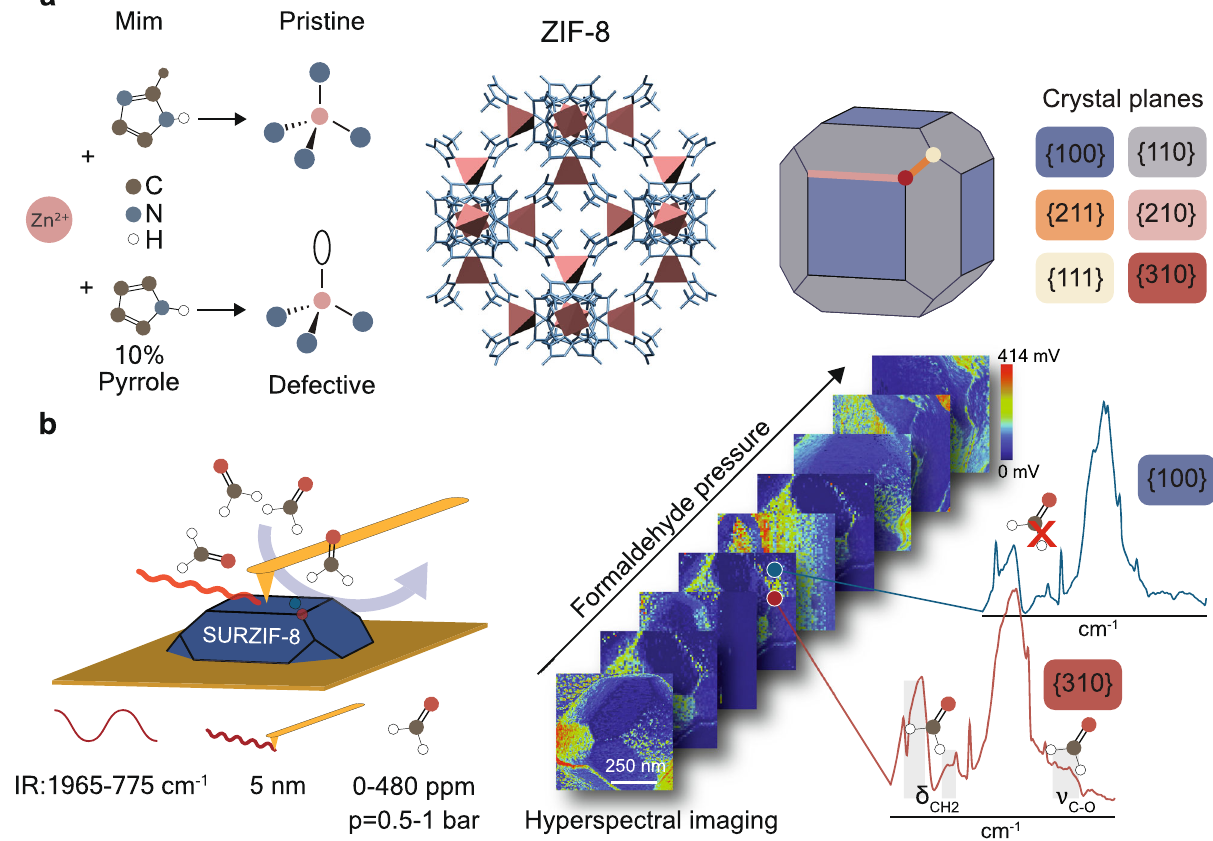
Fig. 1 | Experimental approach. Nanoscale guest – host interactions were studied by: a Synthesizing(defect-engineered)surface-anchoredZIF-8microcrystals(Mim: 2-methylimidazole).ThestructureofZIF-8microcrystalsisshownontheright,with color-coded crystal plane terminations; b Applying in situ photo-induced force